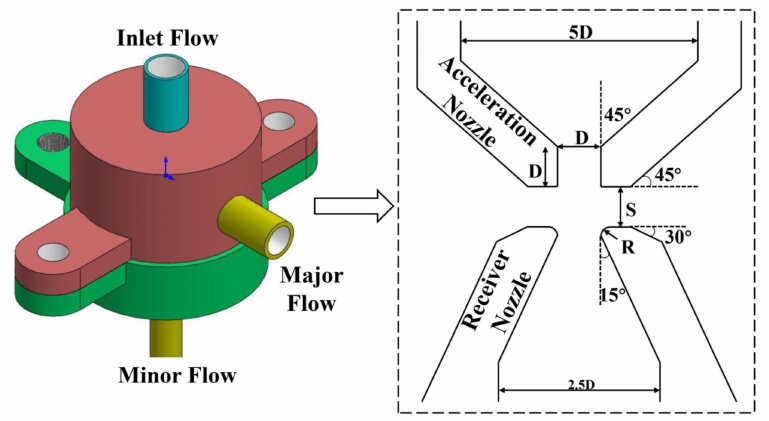
Figure 2. Schematic view of the